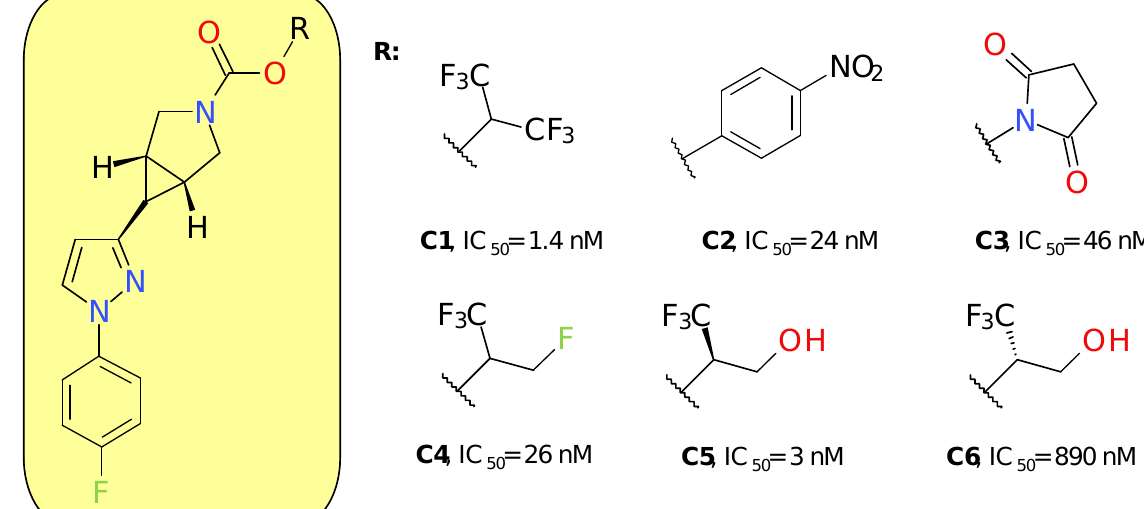
Figure 5. Irreversible MAGL inhibitors—azabicyclo[3.1.0]hexane trifluoromethyl glycol carbamates and related struc- tures.